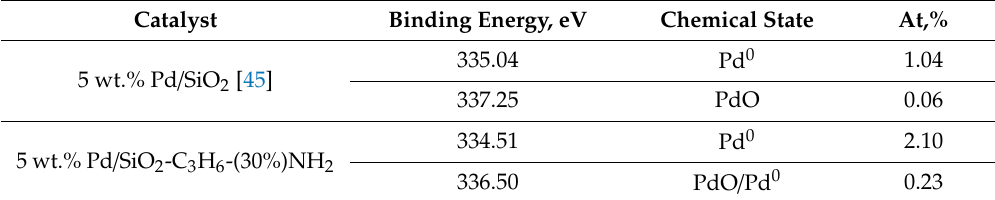
Table 3. The spectrum data of catalysts after used in reaction.